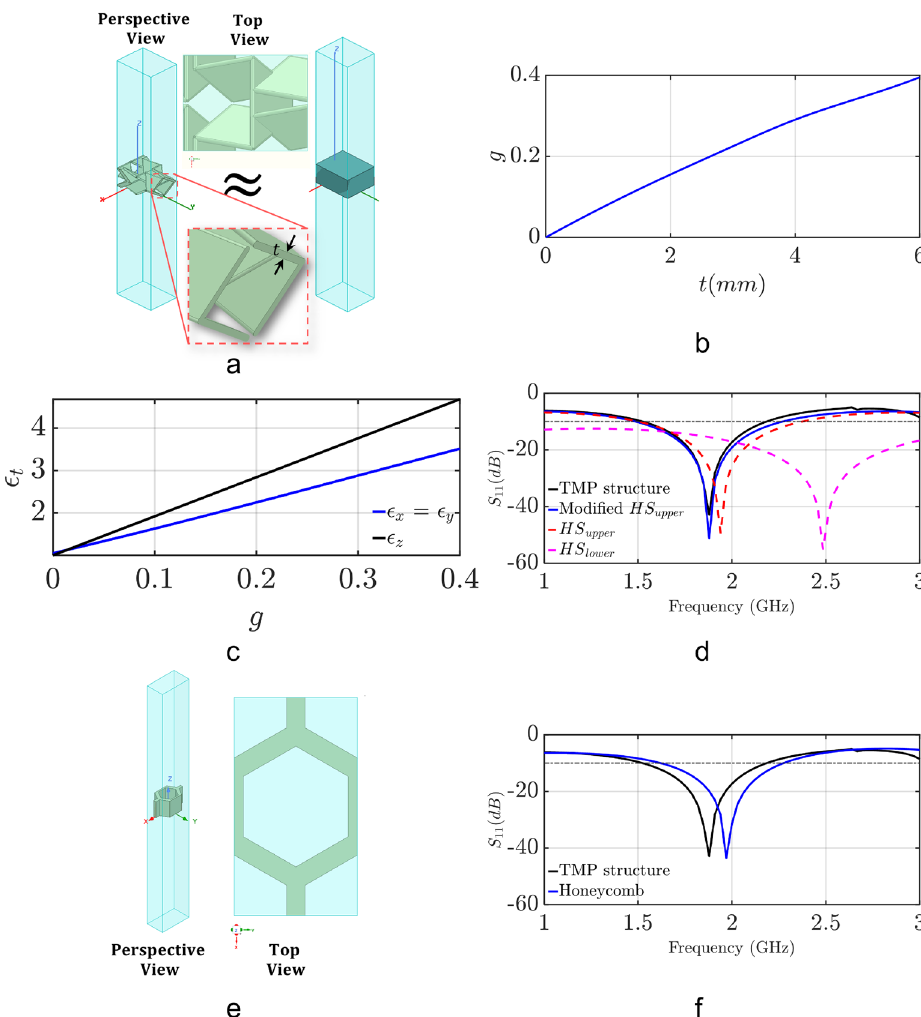
Figure 4. Effective material homogenization analysis of the dielectric structure of our TMP absorber (no metal and resistive layers are included). ( a ) Perspective and top views of our TMP absorber, and its equivalent homogenized model for wall thickness t = 4 mm. A step-by step design process for the 3D structure of our TMP absorber is presented in Figs. S4 and S5 of our Supplementary Material in Section 2.2. ( b ) Volume fill factor, g , response as the wall thickness, t , varies from 0 to 6 mm. ( c ) Relationship between ε t and volume fill factor, g . ( d ) Evaluated reflection coefficients of TMP absorber following different approaches. ( e ) Perspective and top views of a honeycomb unit cell. ( f ) Reflection coefficients of the honeycomb and TMP unit